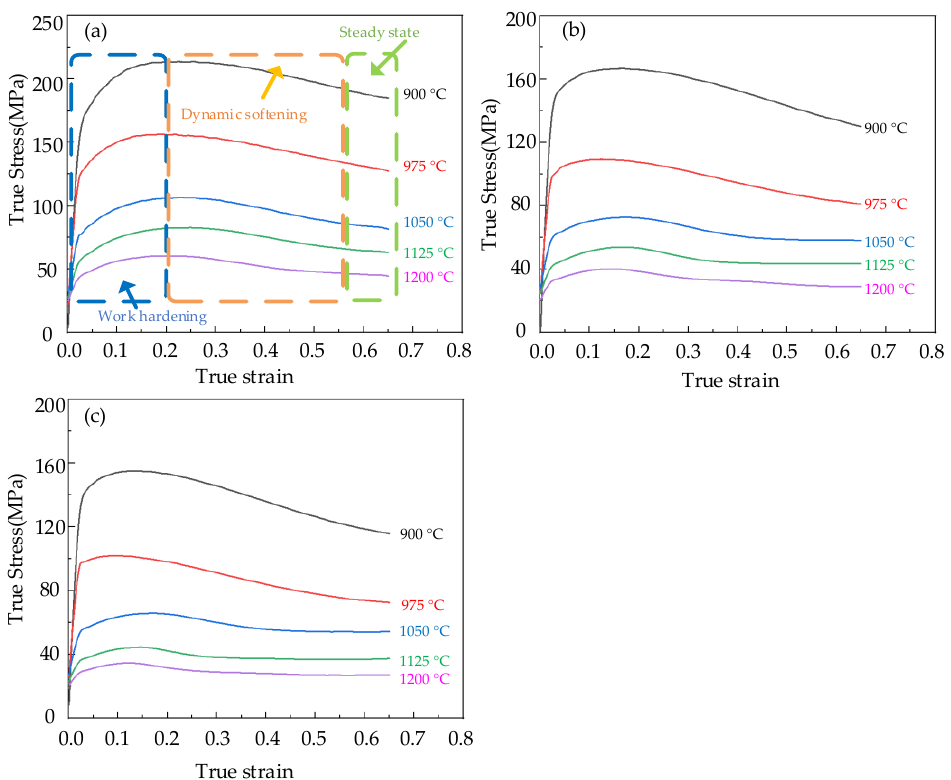
. ε = 0.1 s − 1 ;  = 0.1 s −1 ; ( b )